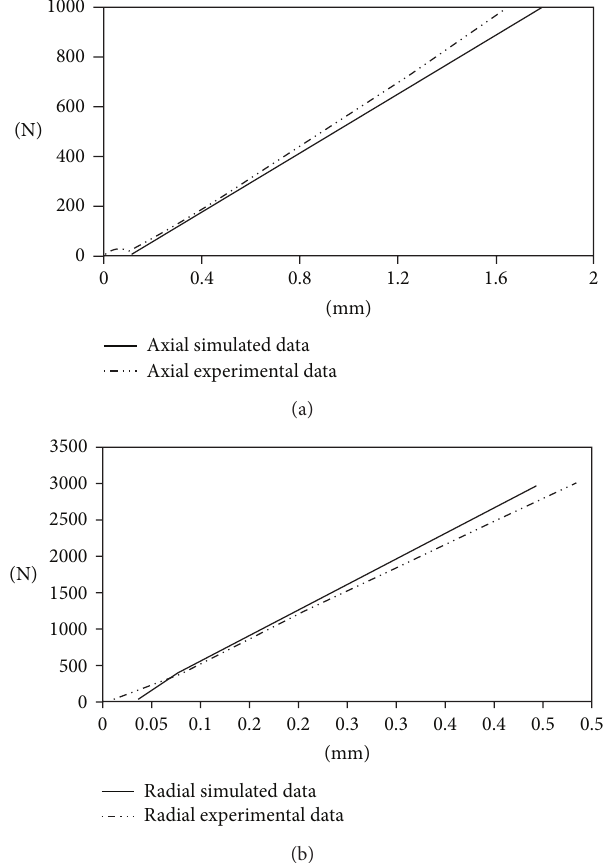
Figure 6: The load-displacement curves (after optimization).